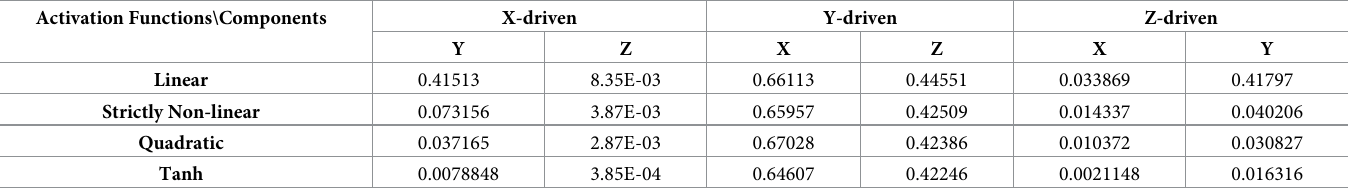
Table 5. Mean square error (MSE) for chaotic system in Experiment set 2. Activation Functions\Components